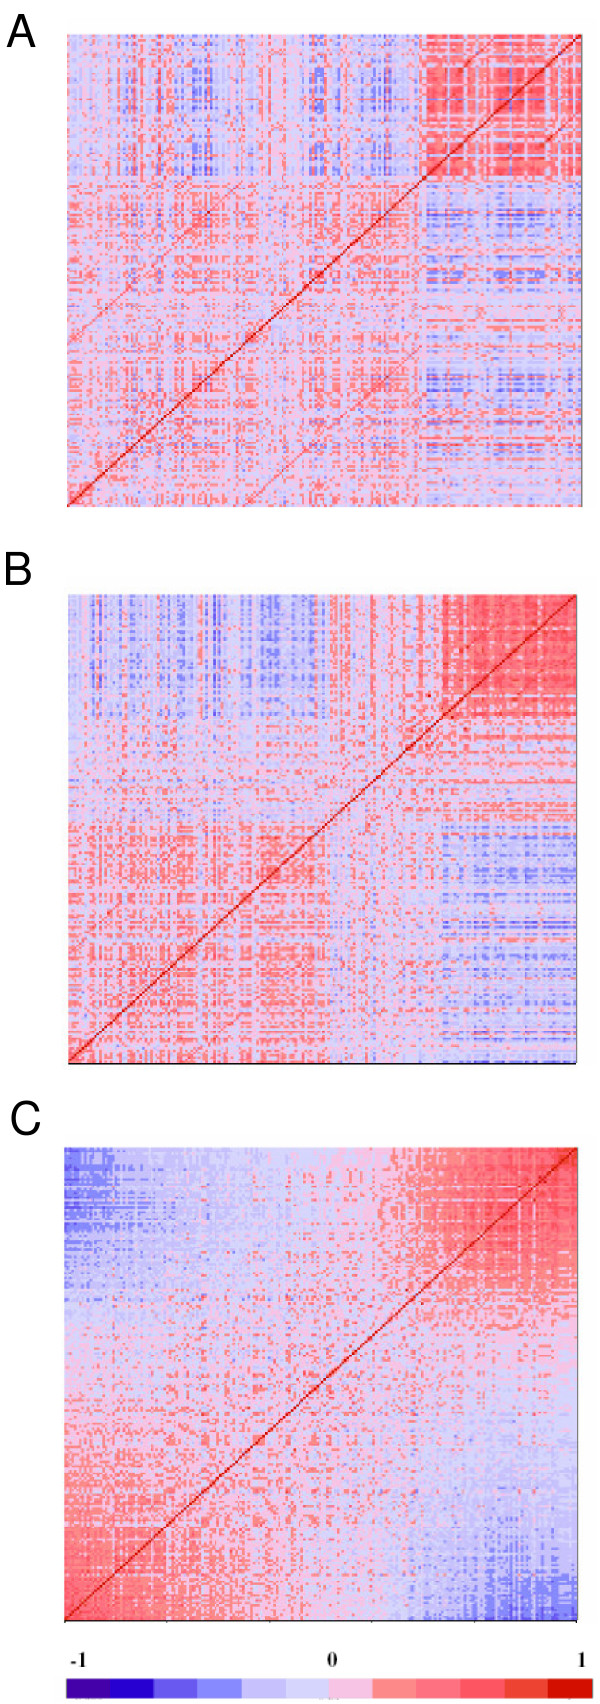
From discrete classification to grades of membership. a. The same correlation matrix as in Figure 1b but with samples re-grouped so that the Type 1 samples are on the lower left side, showing that samples can be classified into two main types of expression patterns. b. The same samples can be subdivided into three classes, and re-ordered accordingly in the correlation heatmap, still showing reasonably strong distinction between the three classes. c. The same heatmap re-ordered by the first Principal Component scores, resulting in a gradual progression from one prototype to the other.